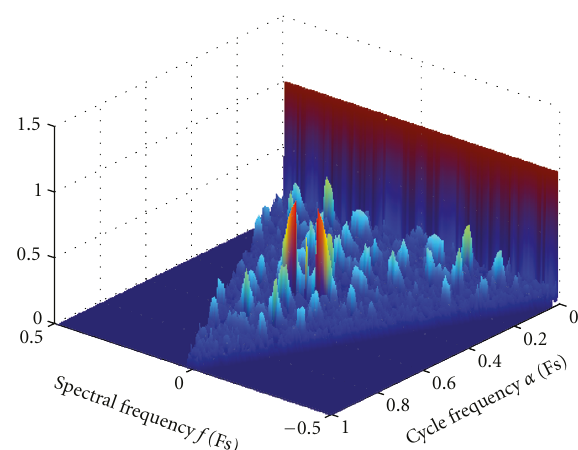
Figure 1: SOF of a BPSK signal in an AWGN Channel at 5 dB SNR, with 1 / Ts = Fs / 10, Fc = 0.25 Fs, no. of samples = 4096.